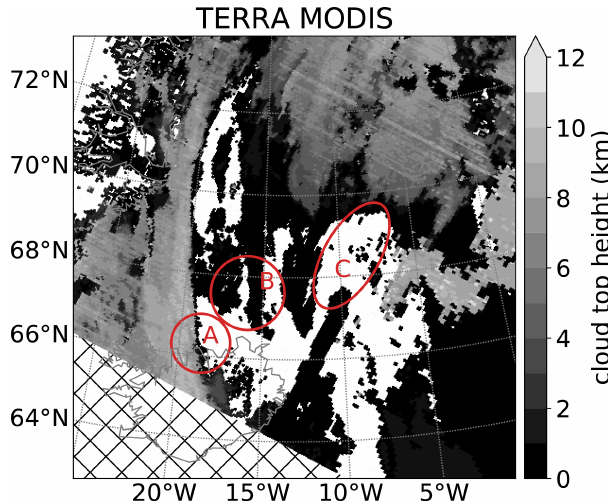
Figure 15. The cloud top altitude L2 product of MODIS on TERRA taken on 18th September 2017 around 13:08UTC. White indicates no recognized cloud. The three red ellipses mark areas of interest. Hatched areas indicate missing